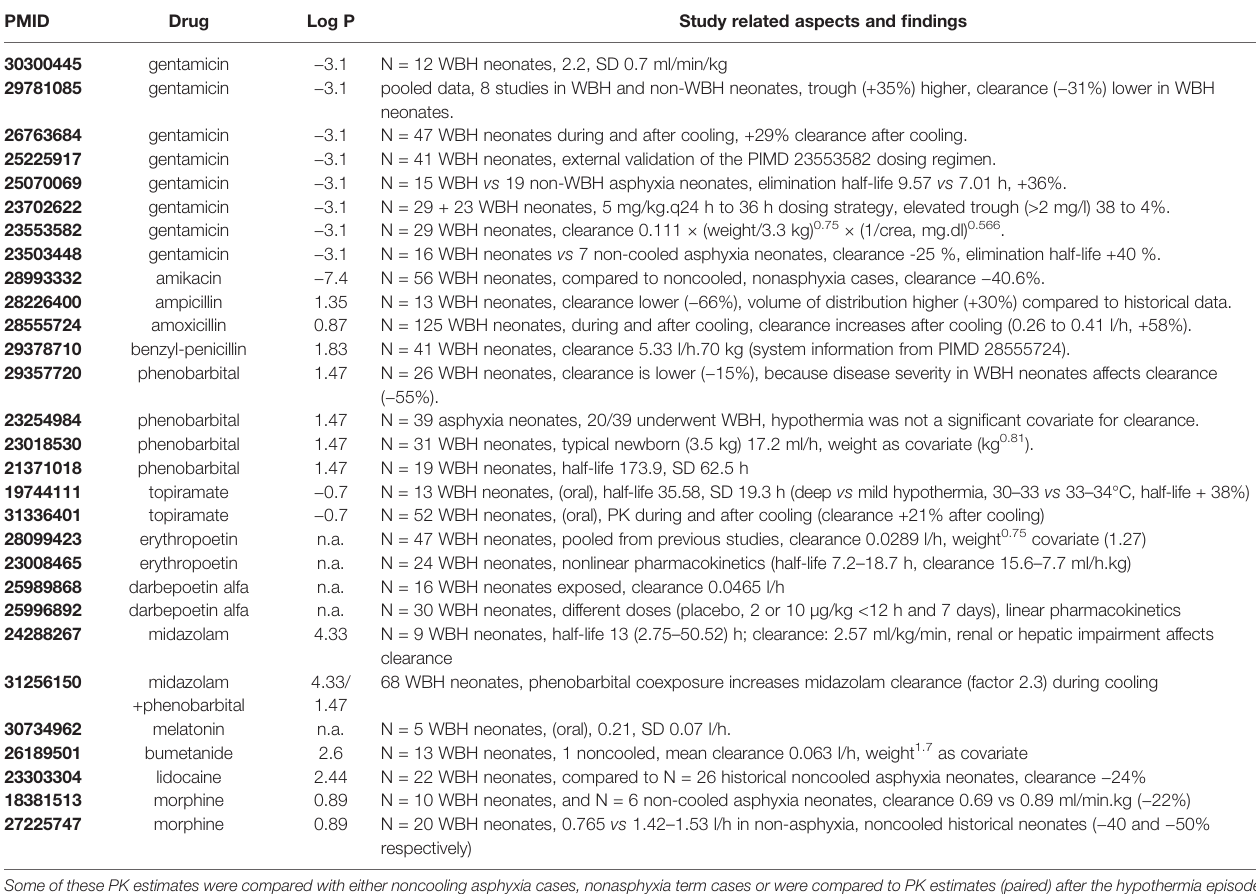
TABLE 1 | Overview on the pharmacokinetics (PK) of drugs in neonates undergoing therapeutic hypothermia (TH), obtained by a structured Pubmed search. PMID Drug Log P Study related aspects and fi ndings